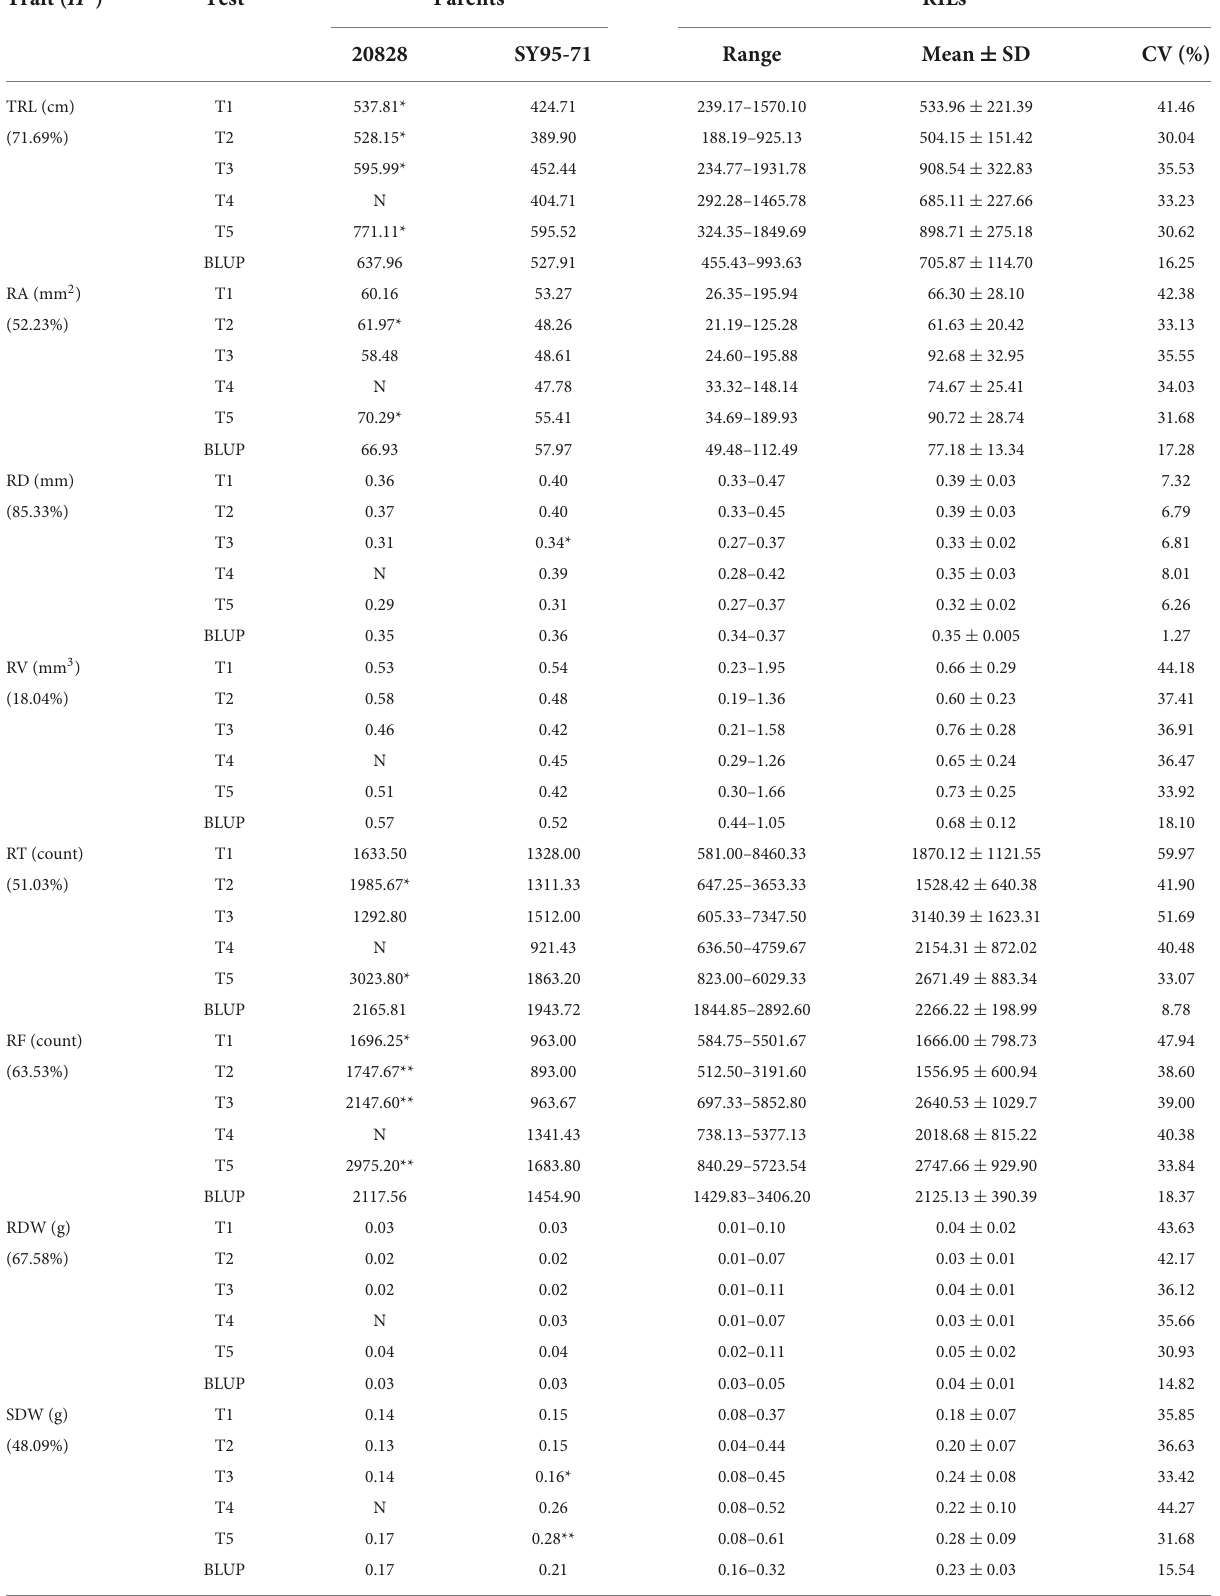
TABLE 1 Phenotypic variation of RSA-related traits from five independent tests in 2SY